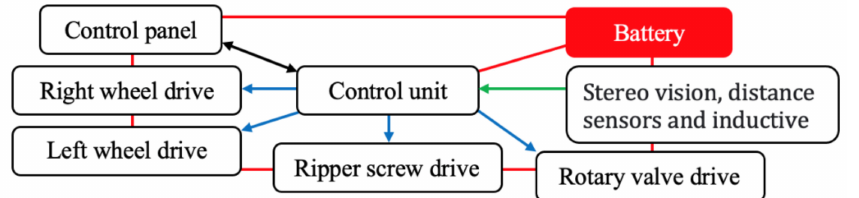
Figure 6. Functional diagram of the pusher